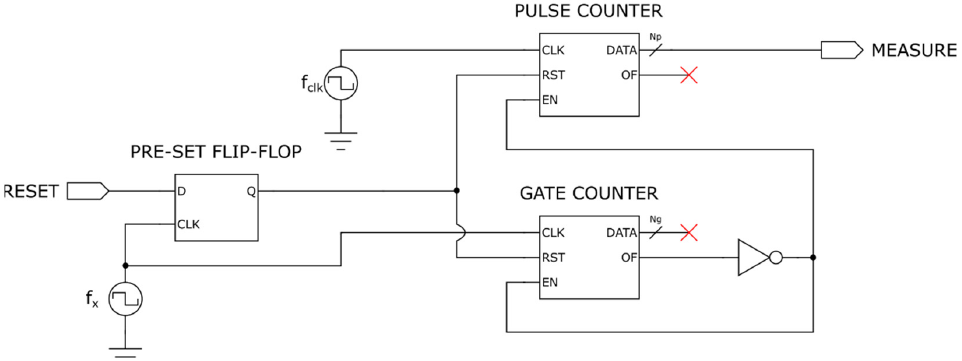
Figure 3. Structure of an equal precision reciprocal frequency counter.